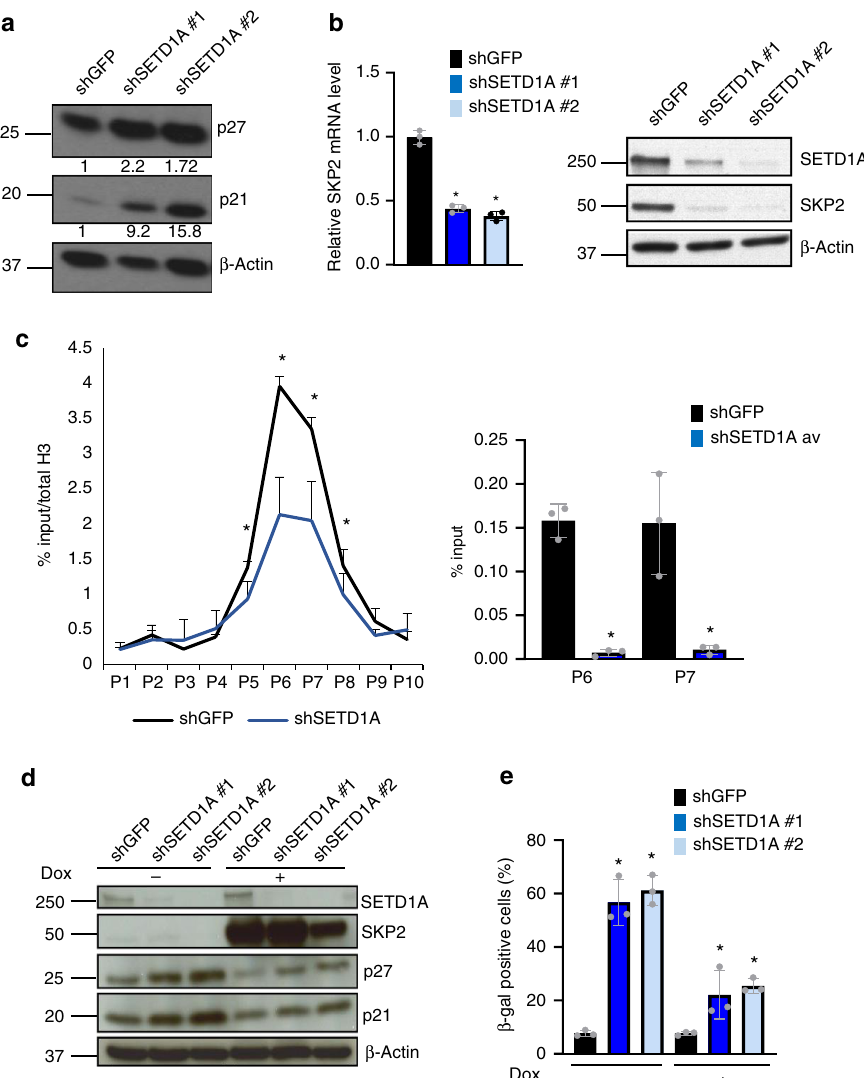
Fig. 5 SKP2 mediates senescence-associated cell cycle arrest in SETD1A-KD cells. a Western blot analysis of shGFP- and SETD1A-KDcells shows induction of p21 and p27. ß-actin is shown as control. Quanti fi cation of the bands is provided below each blot. b SETD1A-KD suppresses SKP2 expression. Left: Bar graph shows the quanti fi cation of SKP2 mRNA in shGFP control and shSETD1A cells. Data from three independent experiments are presented as Mean + SD; * p < 0.05 by two-tailed unpaired Student ’ s t test. Source data are provided as a Source Data fi le. Right: Western blot analysis of SETD1A and